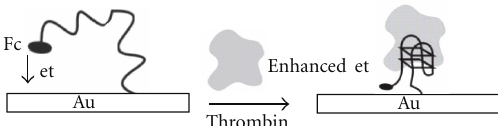
Figure 4: Electrochemical aptasensor based on the binding-in- duced folding of aptamers. In the absence of thrombin, the aptamer is largely unfolded, allowing for frequent collisions between the terminal redox moiety and the electrode. Upon target binding, the aptamer folds, enhancing electron transfer and producing a signal- on